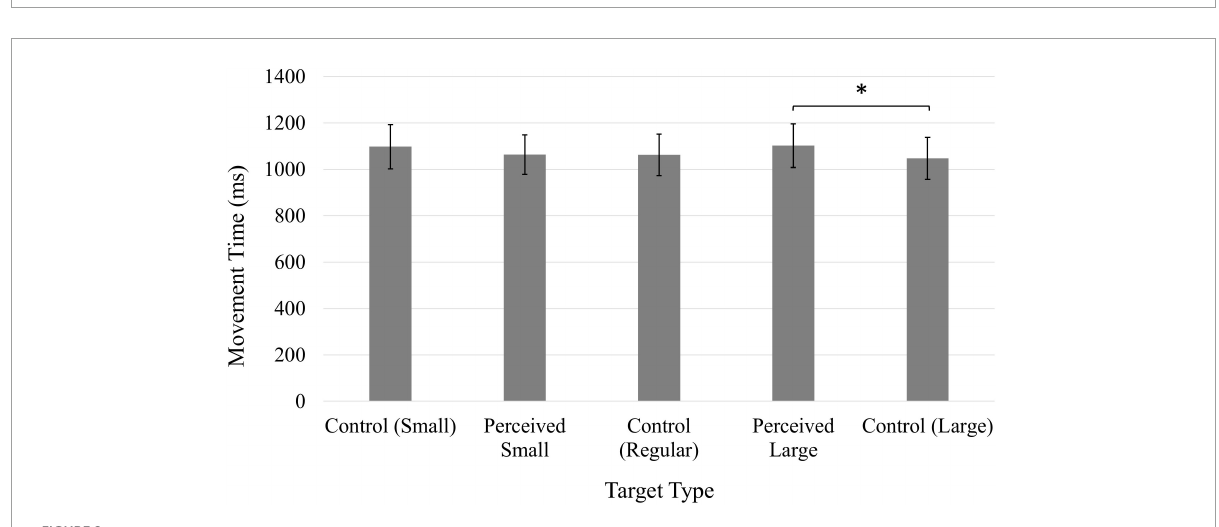
FIGURE2 Average movement time (ms). Error bars represent 95% confidence intervals. ∗ p < 0.05.